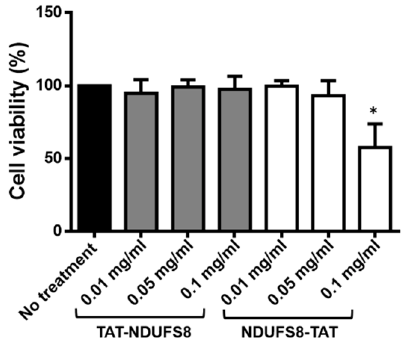
Figure 3. Transduction of exogenously produced TAT-NDUFS8 and NDUFS8-TAT across the mitochondrial inner mem- brane was independent of ΔΨ m. ( a ) The effects of trypsin treatment on the mitochondrial targeting and processing of TAT-NDUFS8 or NDUFS8-TAT introduced by protein transduction. After protein transduction and subcellular fraction- ation, the mitochondrial fractions were treated with or without trypsin. ( b ) The effects of FCCP treatment on the protein translocation of TAT-NDUFS8 or NDUFS8-TAT across the mitochondrial inner membrane. Cells were cultivated with or without FCCP for 18 h, followed by protein transduction with TAT-NDUFS8 or NDUFS8-TAT for another 3 h. ( a , b ) After subcellular fractionation, immunoblotting analysis was performed. The His-tagged fusion proteins were detected with anti-His antibody. The protein markers of the obtained fractions were detected with specific antibodies to verify the correct subcellular fractionation and used as the loading controls: β -tubulin and GAPDH were used as cytosolic markers; ATPase α subunit was used as an inner mitochondrial membrane marker; Tom20 was used as an outer mitochondrial membrane marker; NDUFS3 was used as a mitochondrial matrix marker.